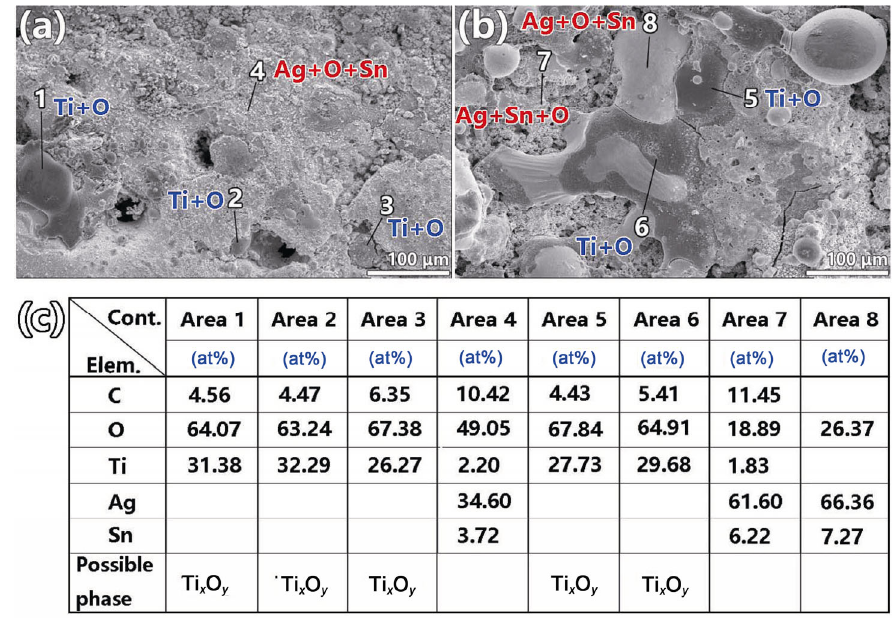
Fig. 12 Elemental composition on the surface of the Ag/TSC contacts: (a) Ag/10TSC, (b) Ag/20TSC; (c) EDS results of different areas.